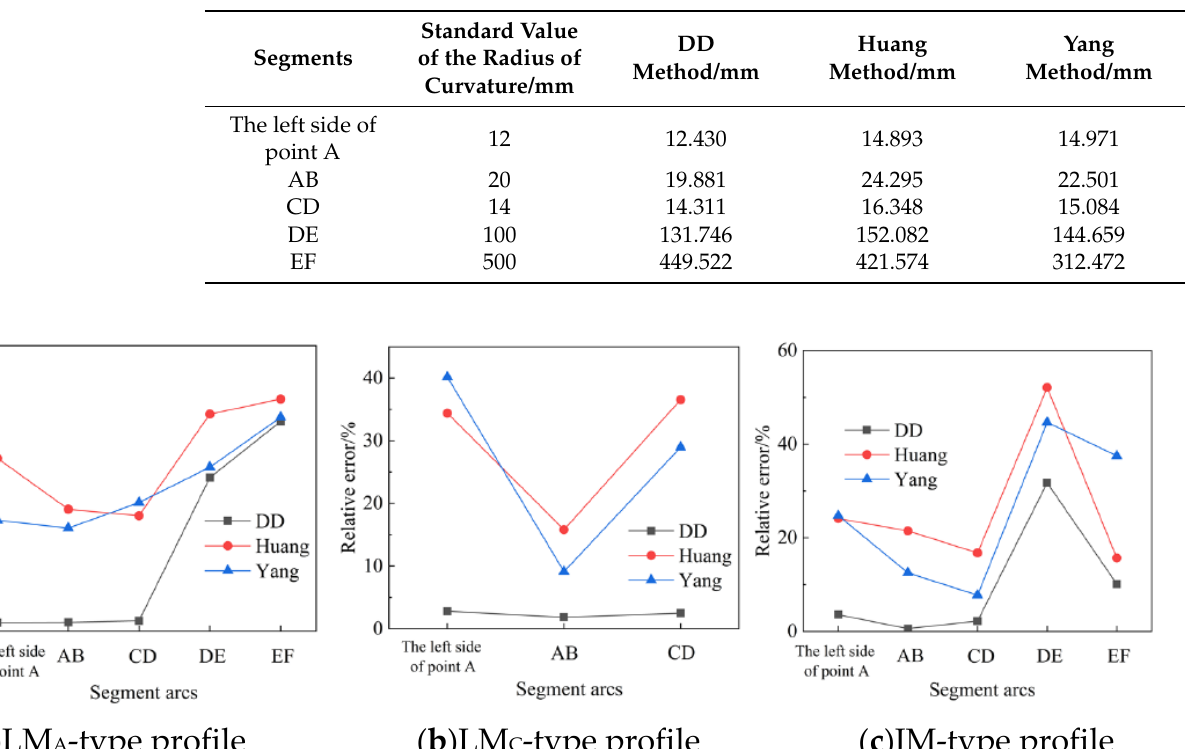
Table 6. The results of calculating JM-type profile’s radius of curvature.